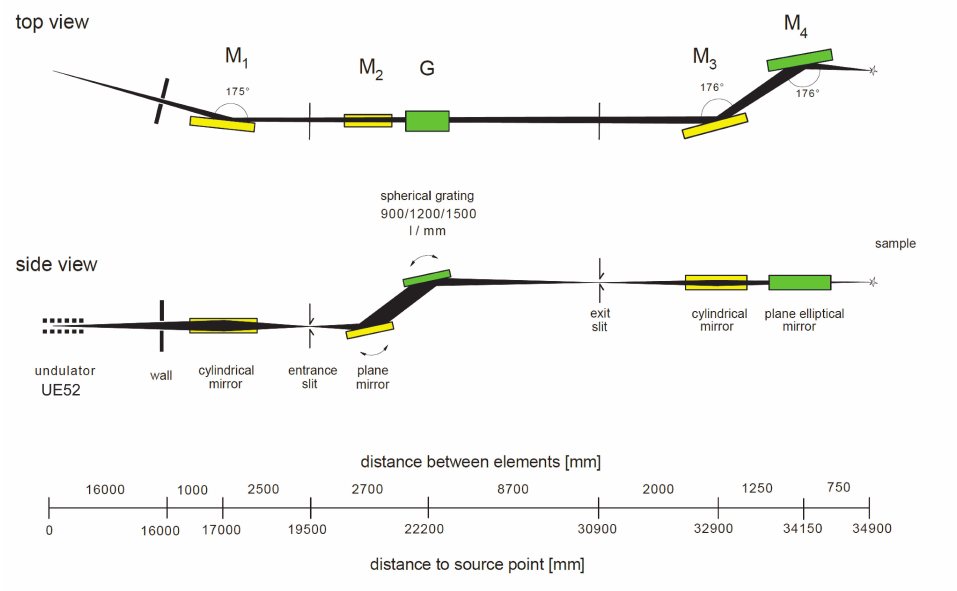
Figure 2: Optical layout of beamline UE52 SGM (modified from Senf et al.